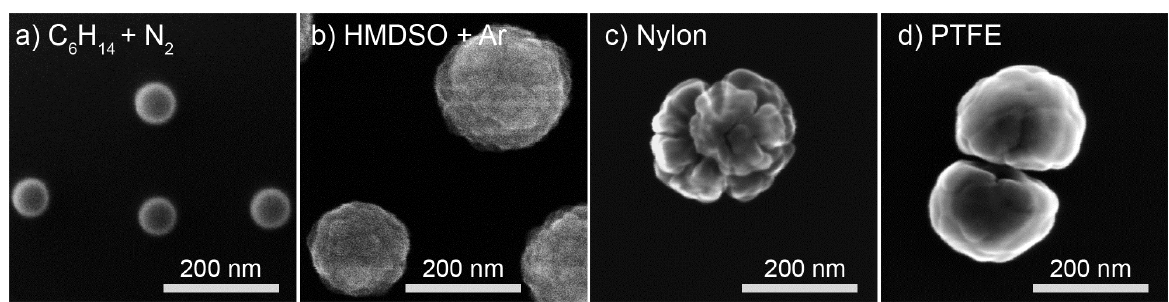
Figure 2: SEM images of different types of plasma polymer nanoparticles produced: a) by plasma polymerization of n -hexane in its mixture with N 2 ; b) by plasma polymerization of HMDSO in its mixture with Ar (obtained in a similar manner as [53]); c) by RF magnetron sputtering of nylon in the Ar/N 2 mixture (republished from [54] with permission IOP Publishing Ltd.); d) by RF magnetron sputtering of PTFE in Ar (obtained in a similar manner as [55]). The references shown here and in the following figures cite the authors’ previous works where similar (but not necessarily identical) data were presented; the unreferenced data represent the authors’ new material which has not been published yet, but which is necessary for a compara- tive analysis in this